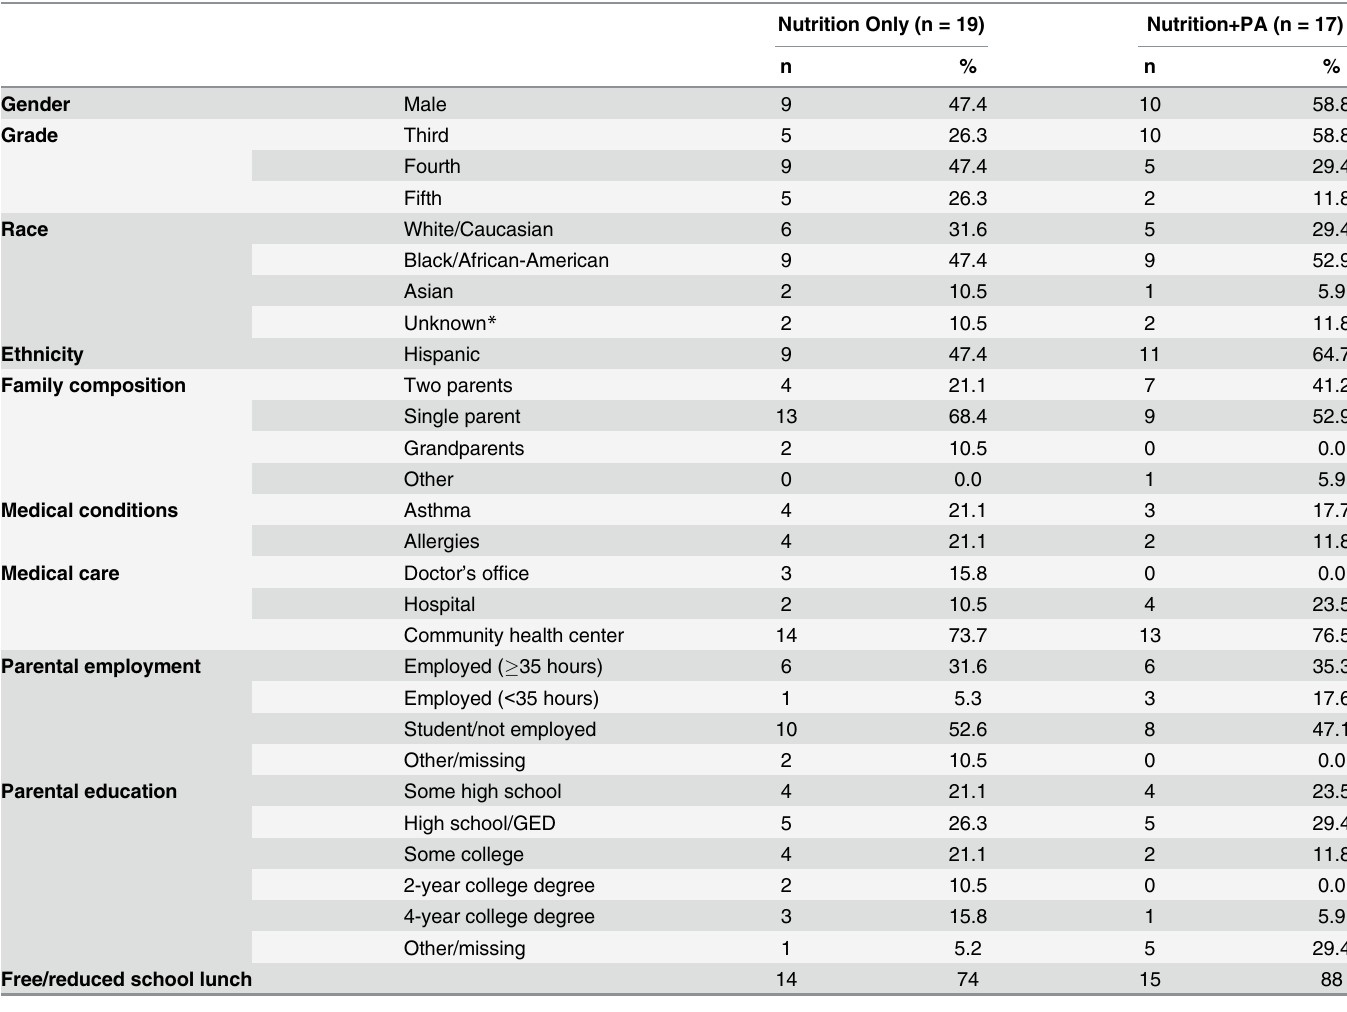
Table 1. Sociodemographic characteristics for all enrolled participants with baseline and follow-up measurements (n =